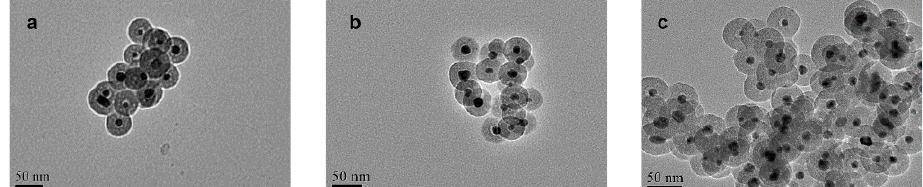
Figure 8. Characterization of the nanoparticles prepared by CH 2 O after reaction by TEM images: ( a )NB / under H 2 , ( b ) without NB / under H 2, ( c ) NB / under Ar.